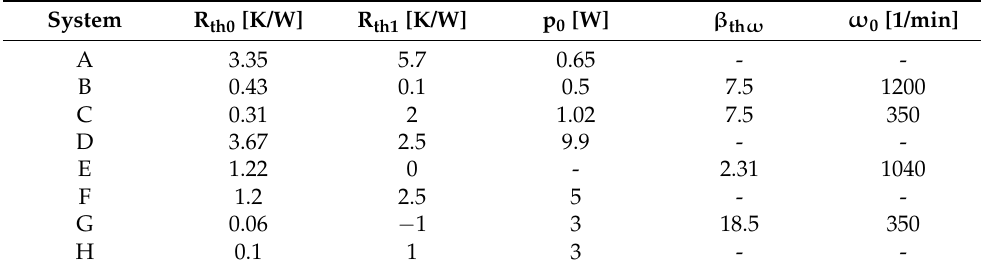
Table 2. Values of R thm (p, ω ) model parameters for the tested cooling